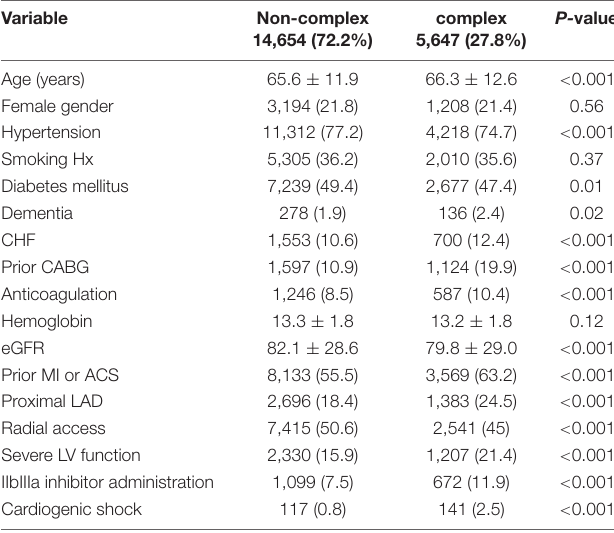
TABLE 1 | Baseline characteristics, complex vs. non-complex PCI.